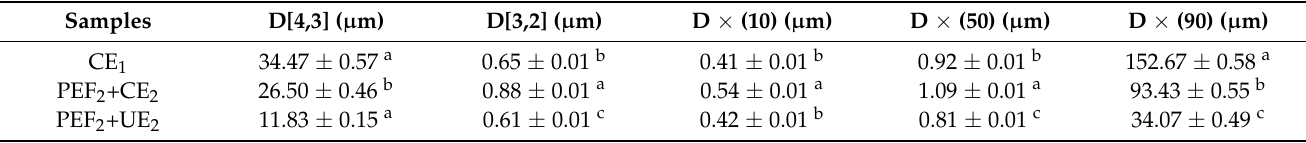
Figure 4. The particle size distribution of Se − TPSs obtained using different extraction methods. Table 3. Particle size distribution of Se − TPSs